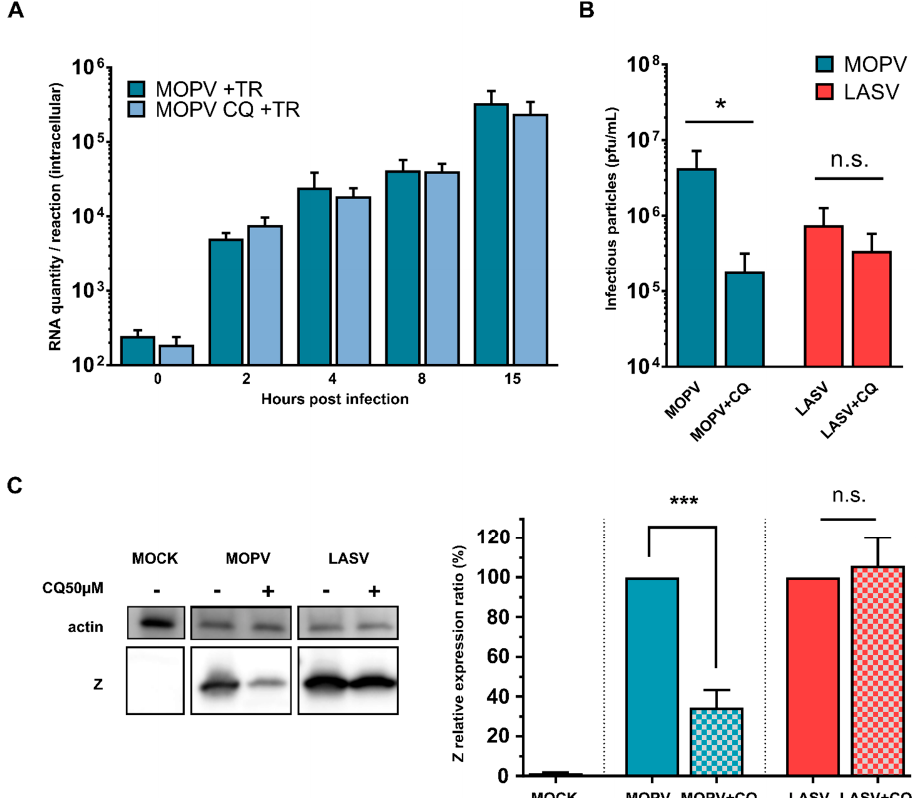
Figure 5. Degradative steps of autophagy increase MOPV infectious particle production. ( A ) Hela cells were pretreated with 50 µM CQ for 2 h and placed on ice before infection with MOPV at an MOI of 2. Cells were then placed on ice before proceeding to heat shock (37 °C). At the indicated timepoints, attached virus was removed by trypsin treatment (TR), and viral intracellular RNA harvested for RTqPCR analysis. ( B ) HeLa cells were infected with LASV or MOPV at an MOI of 0.1 and then treated, or not, with 50 µM CQ one day after infection for two days. Cell supernatants were then harvested and titrated on Vero cells. The error bars represent the standard error of the means from four independent experiments. * indicates p < 0.05, n.s.: non-significant, as determined by the Mann–Whitney test. The error bars represent the standard error of the means from four independent experiments. ( C ) The same cells as in (B) were lysed and the quantity of Z protein inside the cells has been measured by Western blotting. Representative results are shown, along with a graph representing the intensity of the Z protein bands over actin. The error bars represent the standard error of the means from four independent experiments. n.s. non-significant ; *** p < 0.001, as determined by Student’s t -test.